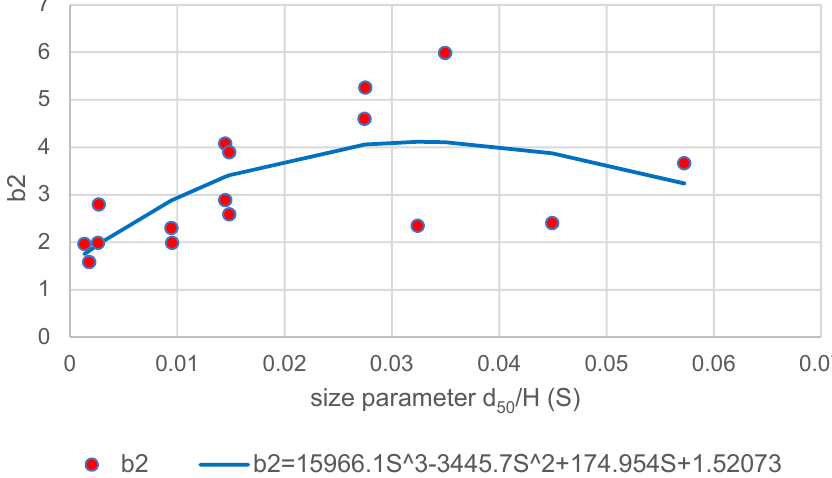
Figure 11. Size parameter vs. coefficient b 2 using KNN ( R 2 = 0.434).